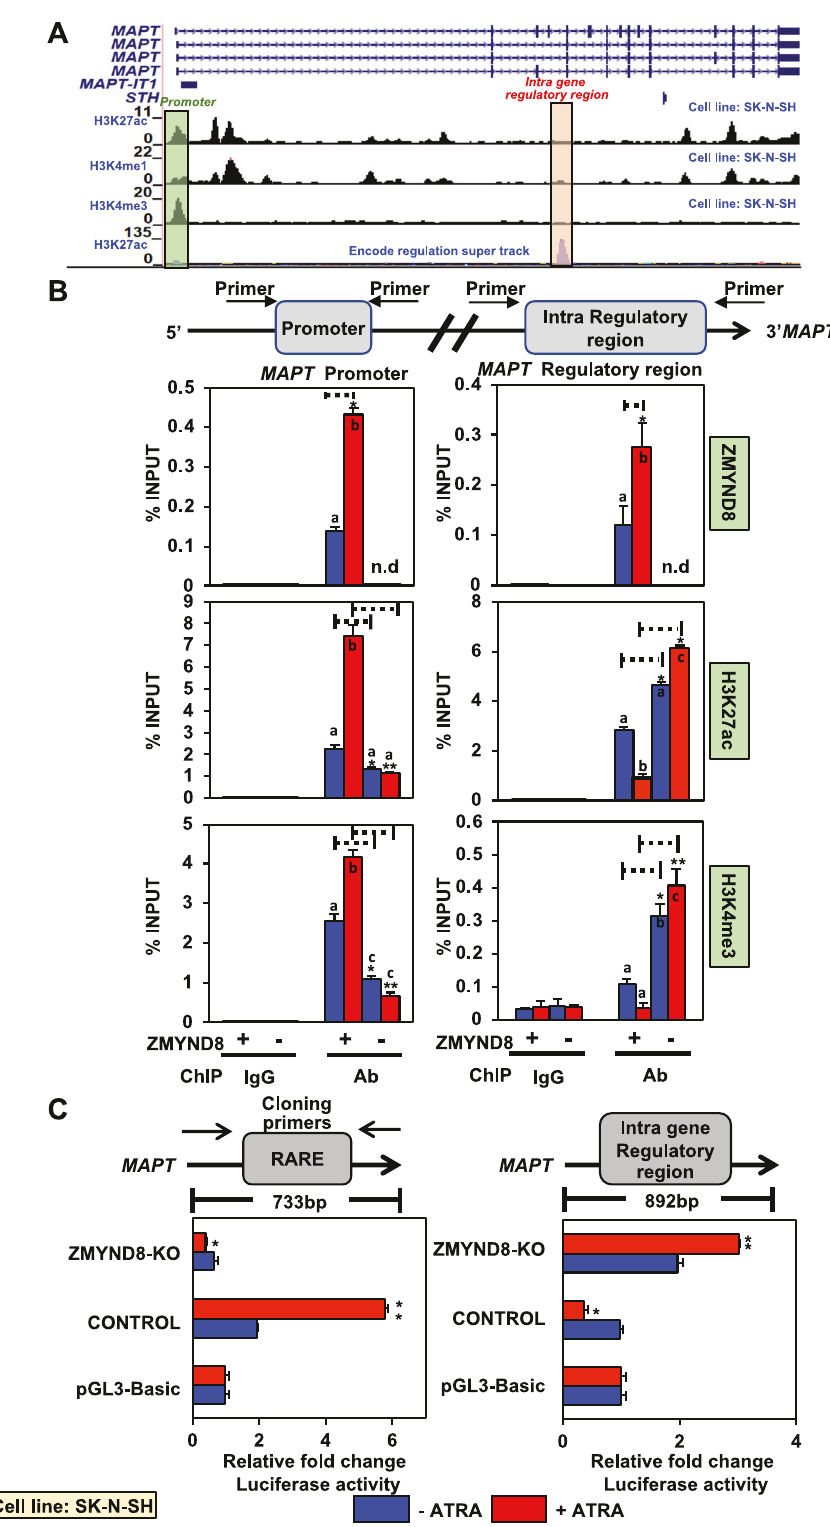
Fig. 4 The absence of ZMYND8 shows increased transcription from MAPT intra-regulatory region. A UCSC Genome Browser track showing the histone modi fi cations (H3K27ac and H3K4me3) at the MAPT gene; data was accessed from ENCODE. B Bar plots of qPCR showing enrichment of ZMYND8, H3K27ac, and H3K4me3 at the MAPT promoter (left panel) or intra-gene regulatory region (IGRR) (right panel) in ZMYND8-knockout (ZMYND8-KO) or control SK-N-SH cells with or without ATRA treatment. C Luciferase assay measuring the fi re fl y luciferase activity of MAPT promoter (left panel) or intra-gene regulatory region (right panel) in ZMYND8 -knockout ( ZMYND8 -KO) or control SK-N-SH cells with or without ATRA treatment. All fi re fl y luciferase activities were normalized to renilla luciferase activity. Error bars indicate sem.; n = 3; three independent experiments. A two-tailed t -test was used to calculate P -values. * P < 0.05; ** P < 0.01. One-way ANOVA was used to compute statistical differences. Boxes marked with a, b, and c are signi fi cantly different from each other padj-value = < 0.05. Cell Death and Disease (2022)